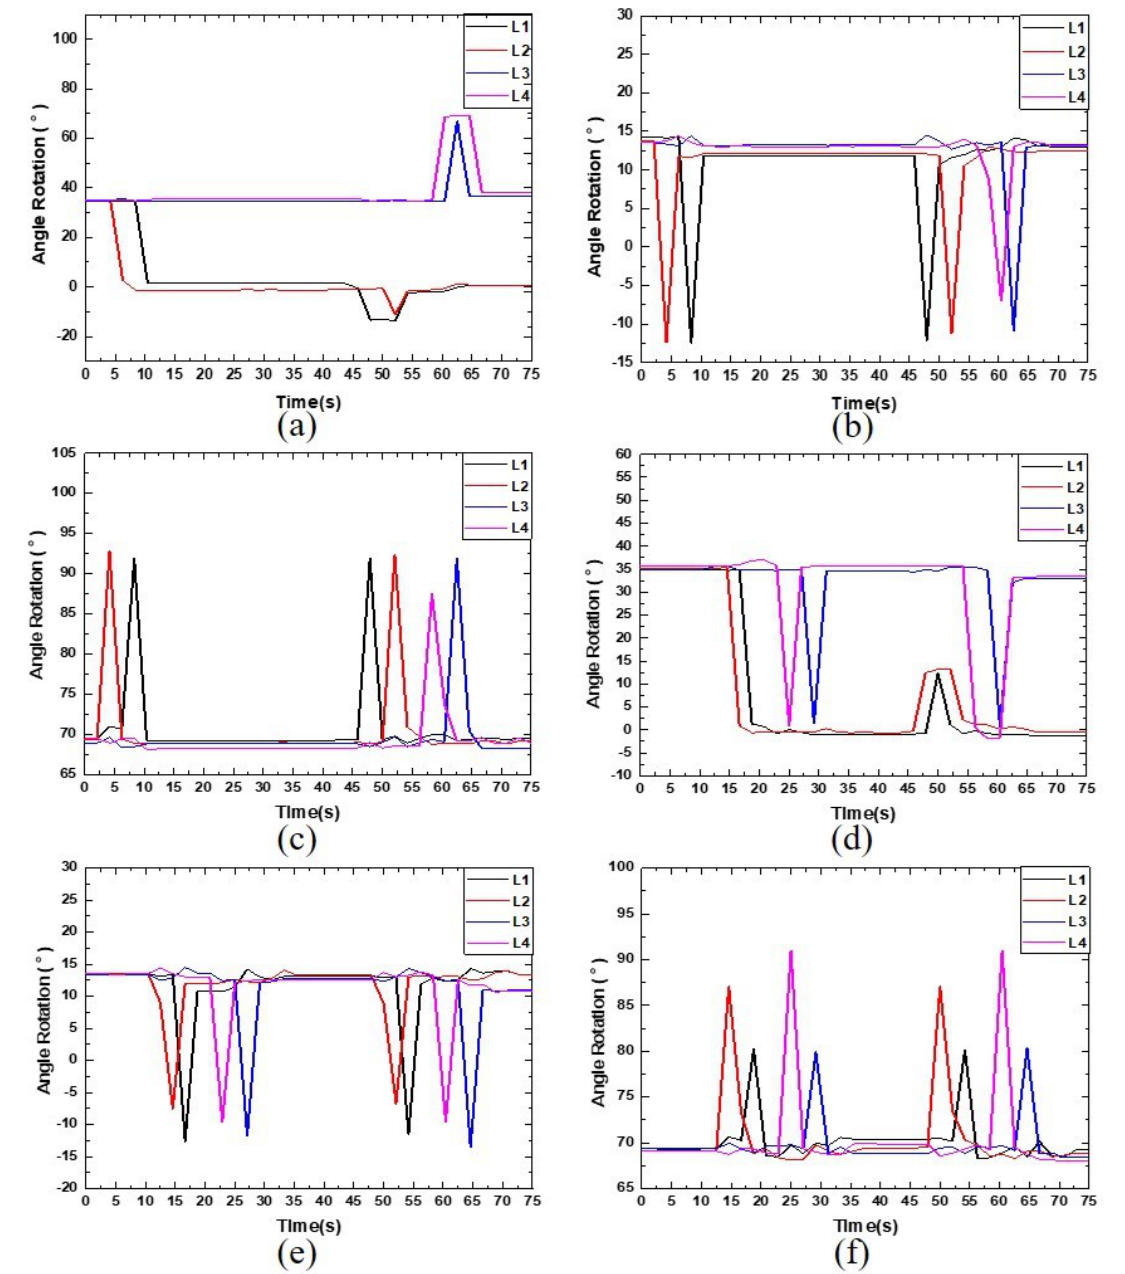
Figure 10. Leg joint angle of rotation for two connected robots walking together. Angle rotation for Robot 1 at ( a ) Joint 1, ( b ) Joint 2, and ( c ) Joint 3. Angle rotation for Robot 2 at ( d ) Joint 1, ( e ) Joint 2, and ( f ) Joint